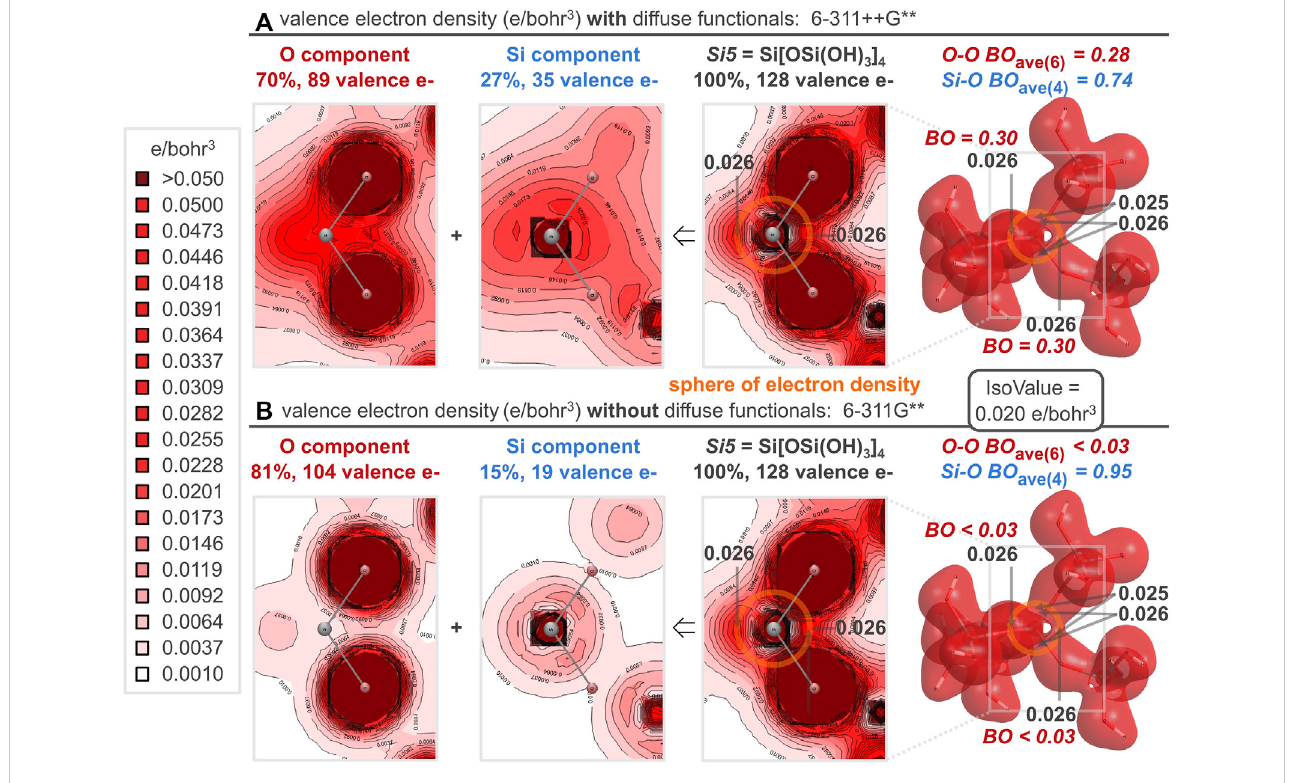
FIGURE 11 For the Si5 silica cluster, the computed valence electron density distribution with diffuse functionals (A) is nearly identical to that without diffuse functionals (B) , despite differential employment of the constituent oxygen and silicon atomic orbitals. This differential accounting of each electron ’ s orbital origin results in non-canonical (A) or canonical (B) O-O and Si-O bond orders. Nonetheless, both computational methods show a spherical node between siliconandoxygen,butade fi nitiveaccumulationofelectrondensitybetweenallgeminaloxygens,resultingina sphereofelectrondensity (orangecircle) responsible for the cooperative bonding in